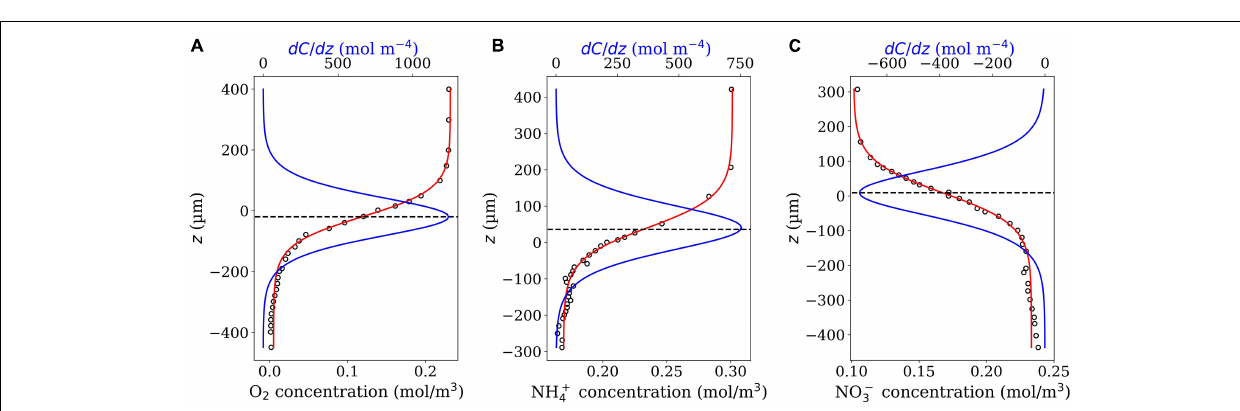
Frontiers in Marine Science |